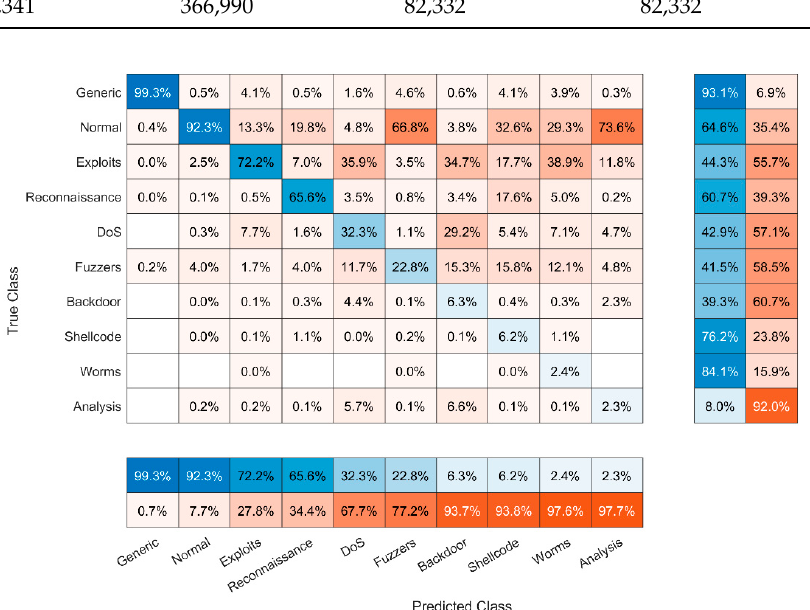
Figure 8. Confusion matrix of detected attacks using ML.NET created on UNSW-NB15 training dataset employing oversampling approach.